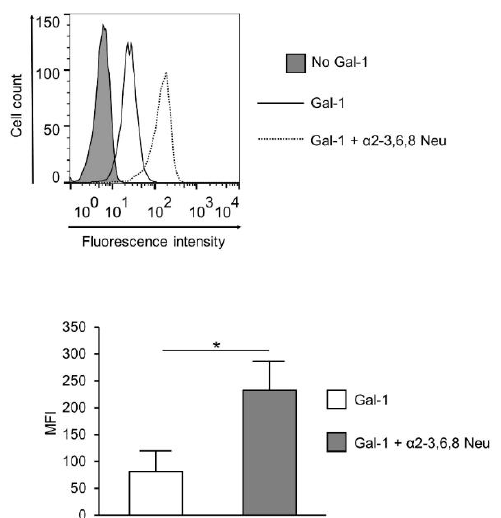
Figure 4. E ff ect of neuraminidase treatment on Gal-1 binding of SLE T cells. Activated SLE T cells Figure 4 . Effect of neuraminidase treatment on Gal-1 binding of SLE T cells. Activated SLE were treated with α 2-3,6,8 neuraminidase (Gal-1 + α 2-3,6,8 Neu; dotted line) or left untreated (Gal-1; T cells were treated with α2 -3,6,8 neuraminidase (Gal-1 + α2 - 3,6,8 Neu; dotted line) or left empty, continuous line), and then Gal-1 binding was investigated by cytofluorimetry, as described in untreated (Gal-1; empty, continuous line), and then Gal-1 binding was investigated by the materials and methods section. The grey shadowed histogram shows the negative control: no cytofluorimetry, as described in the materials and methods section. The grey shadowed Gal-1, + streptavidin—FITC. The upper image shows a representative profile of Gal-1 binding, the lower graph shows means ( ± SEM) of the mean fluorescence intensity (MFI) values of activated SLE histogram shows the negative control: no Gal-1, +streptavidin — FITC. The upper image T cells. Statistical analysis was performed using a two-tailed paired t -test. * p < 0.05, n =